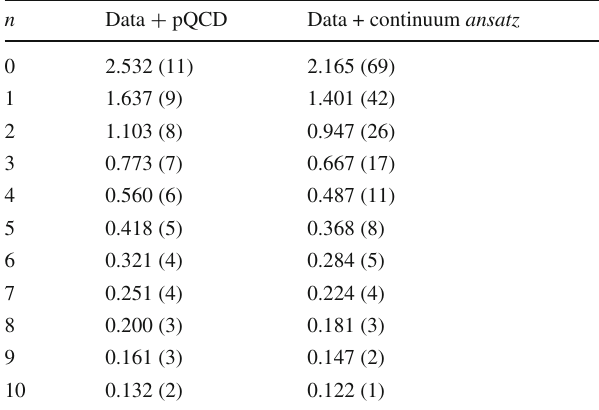
√ s ≤ Table 7 Predictions for the moments in the region 2 M B ≤ 15 . 0 GeV from data and an extrapolation using pQCD including the known heavy quark mass corrections (2nd column) or our ansatz with ˆ m ( ˆ m ) = 4 . 1802 GeV and λ b , exp = 0 . 82 ( 20 ) (3rd column). All num- b b 3 bers are given in units of 10 − ( 2 n + 1 ) GeV − 2 n . Errors in the 2nd column are from experimental moments only as no uncertainty is assigned to the contribution from pQCD. The errors in the 3rd column combine = ± 0 . those from the experimental moments and from (cid:11)λ b 3